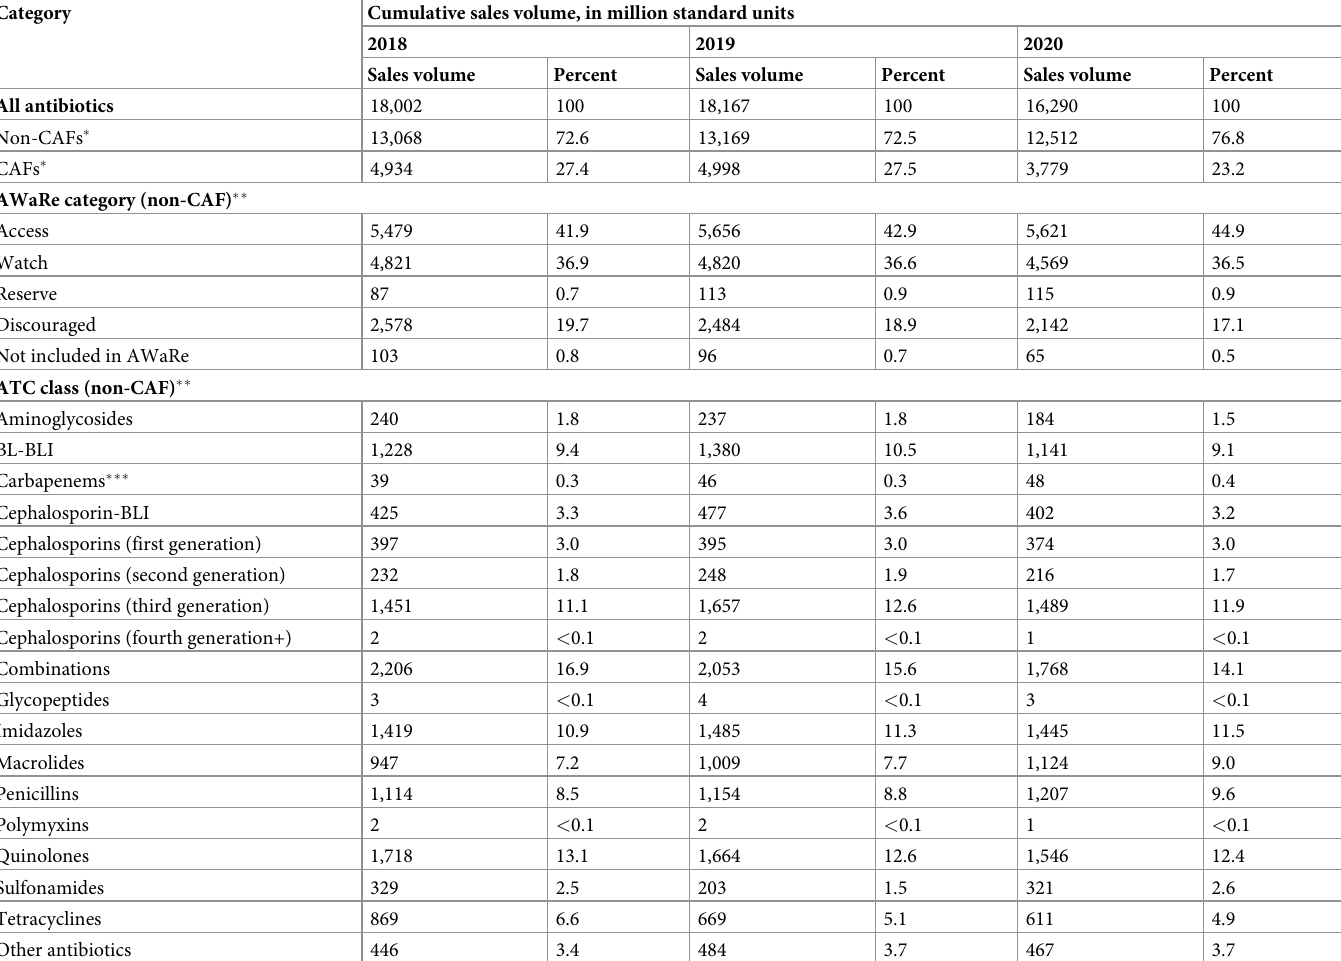
Table 1. Cumulative antibiotic sales volume per year (2018–2020), and distribution by AWaRe category and ATC class for formulations other than child-appropri- ate ones